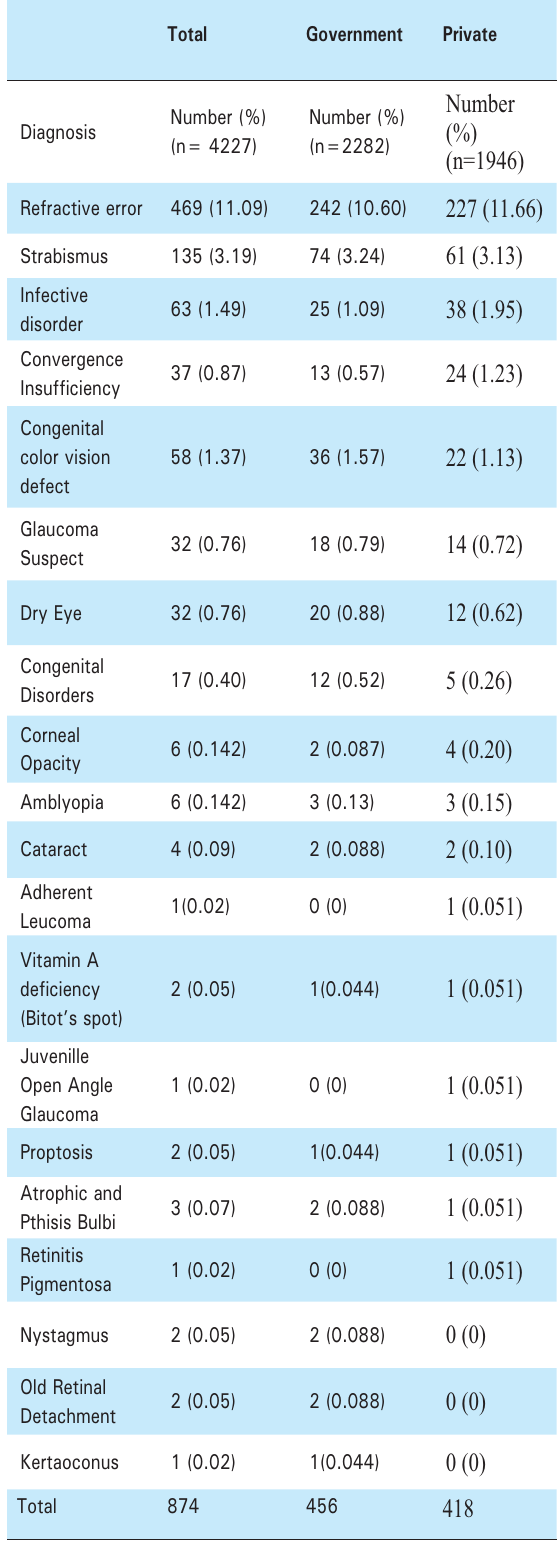
Table 5. Distribution of different ocular